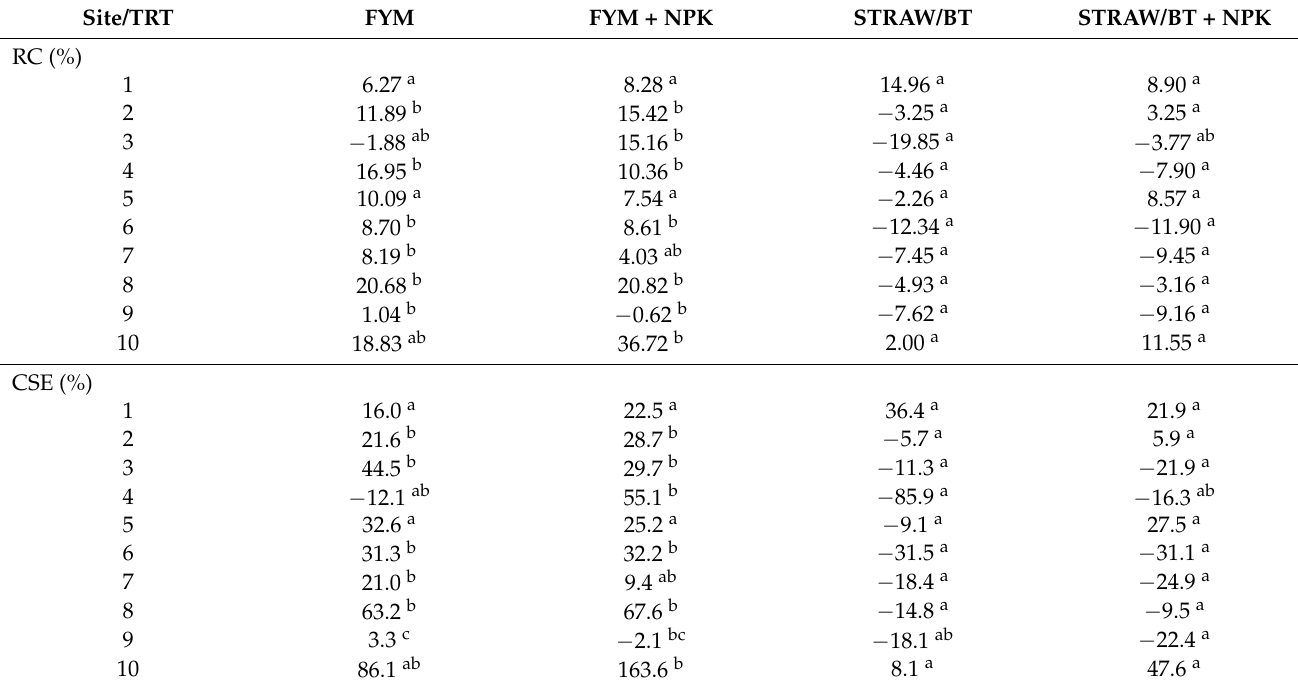
Table 7. The relative contribution of organic fertilizers to soil organic carbon stock (RC) and carbon sequestration efficiency (CSE) at the individual experimental